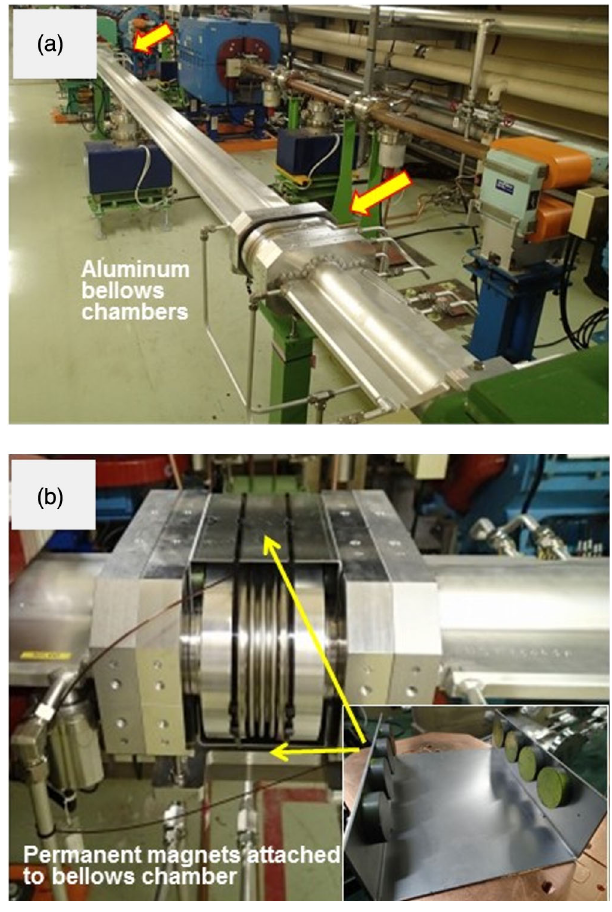
FIG. 11. (a) Al-alloy bellows chambers in the LER and (b) permanent magnets and yokes attached to the chambers.